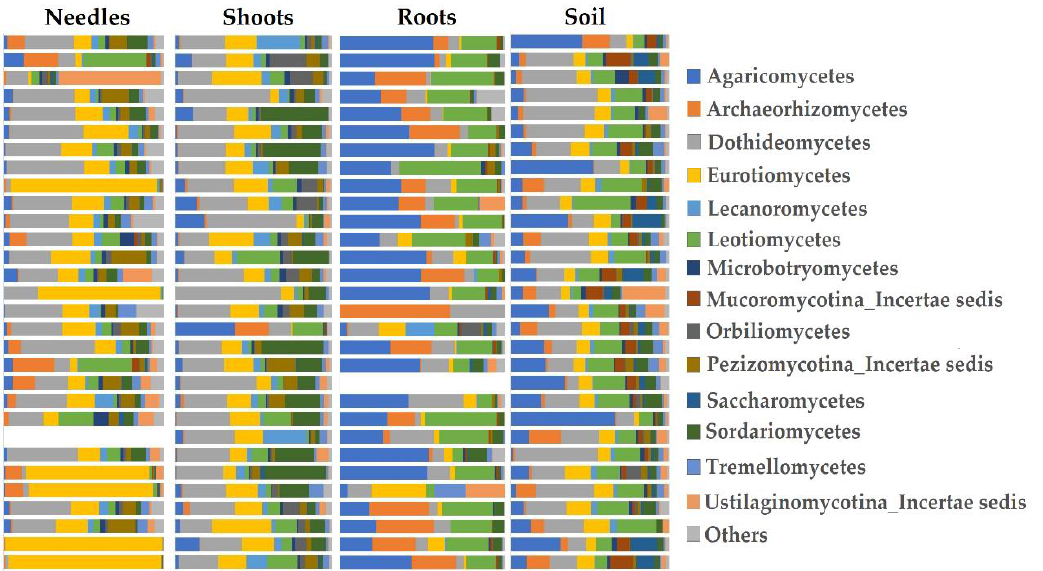
Figure 6. Relative abundance (%) of fungal classes in needles, shoots, roots, and the rhizosphere soil of Picea abies. Others denote fungal classes with a relative abundance of <1%. Site numbers to the left are as in Table 1 and Figure 1. Table 3. Occurrence and relative abundance of the 25 most common fungi (shown as a proportion of all high-quality fungal sequences) found in different substrates. The data from different sites are combined.